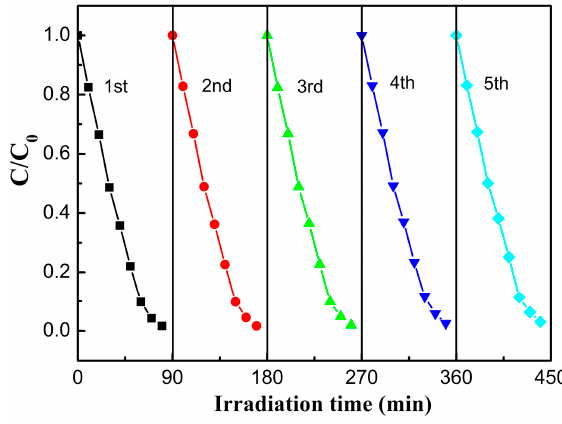
Figure 10. Cycling performance of the photodegradation of RhB solution over the BS-2# sample.